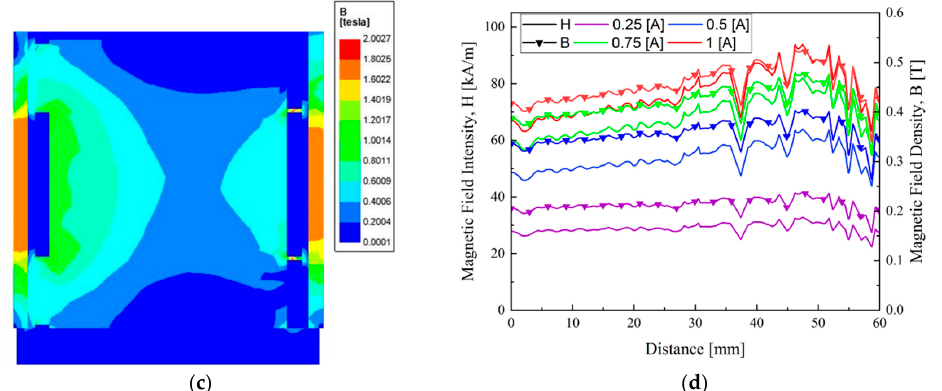
Figure 4. Magnetic field analysis: ( a ) region and contour of the evaluated magnetic field; ( b ) Cross Section 1; ( c ) Cross Section 2; and ( d ) Line 𝑙 − 𝑙′ .